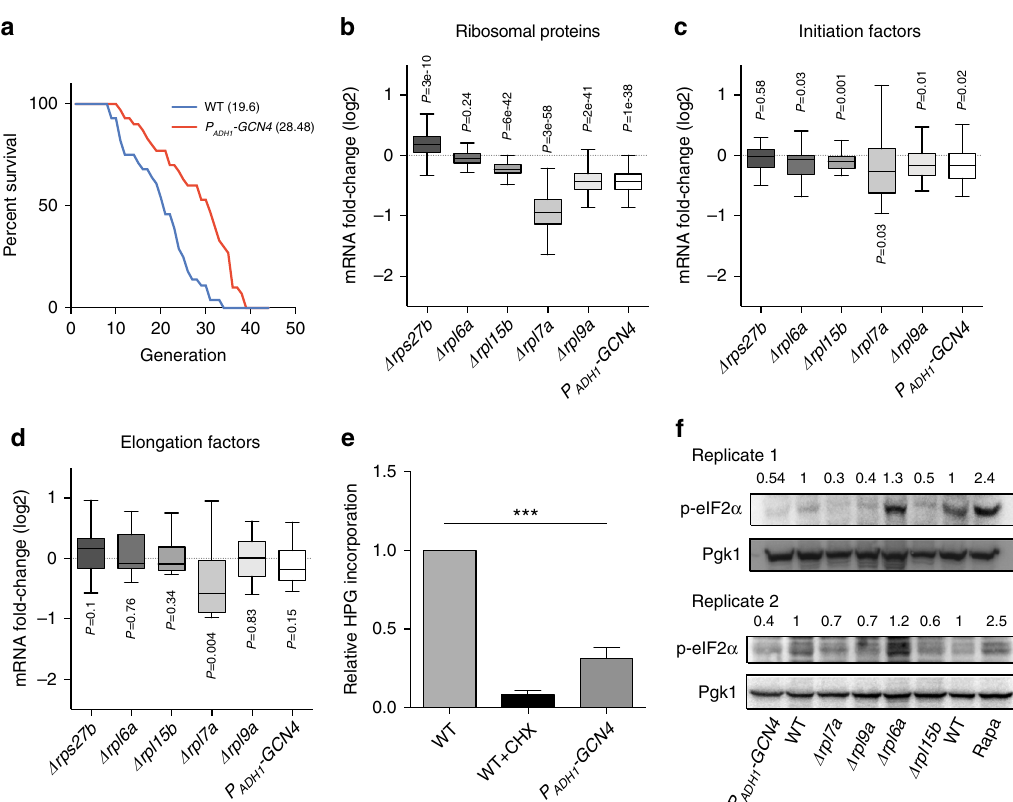
Fig. 5 Gcn4 overexpression increases replicative lifespan and dampens global translation independent of eIF2 α phosphorylation. a The replicative lifespan assay shows that the GCN4 overexpression strain exhibits a ~45% increase in the mean number of generations compared to the wild-type strain. Mean lifespan values are shown in parentheses. b – d Boxplots illustrating the distribution of mRNA fold-change of b ribosomal proteins, c translation initiation factors, and d translation elongation factors in RPKOs and GCN4 overexpression strains relative to the wild-type strain. P -values were calculated using the two-sided Mann – Whitney U test to compare mRNA fold-changes of genes belonging to a given category (RPs, Initiation factors or Elongation factors) and that of all other genes. Boxes extend from the 25th to 75th percentiles, horizontal lines represent the median, whiskers indicate the lowest and highest datum within 1.5*IQR from the lower and upper quartiles, respectively. e Quanti fi cation of global translation by Click-iT HPG shows that GCN4 overexpression strain has a signi fi cantly reduced global protein synthesis. Error bars represent s.d. across three different biological replicates. *** p < 0.001. P -values were calculated using two-tailed Student ’ s t -test. f Quanti fi cation of eIF2 α phosphorylation through western blot. Two different replicates are shown along with their quanti fi cation. Rapamycin vs. vehicle-treated WT was used as positive control for